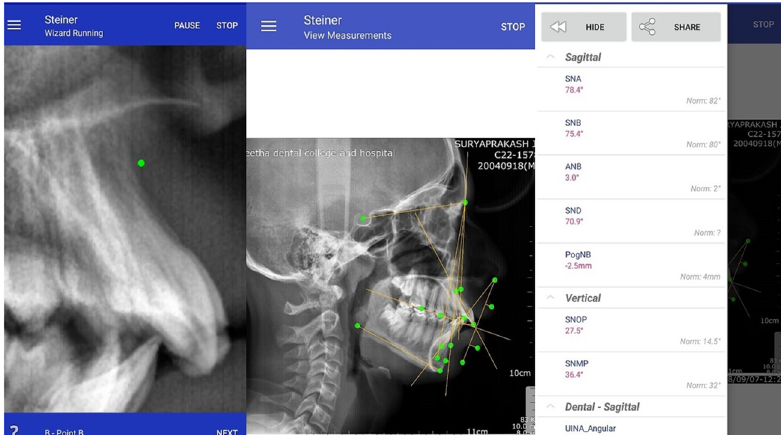
Fig. 1 Digital tracing with OneCeph software. Digital tracing of cephalometric points and analysis done using the OneCeph